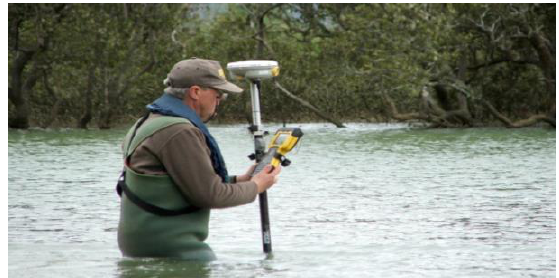
Figure. 1. Example of RTK cross-section survey (Underhill and Smellie, 2009).